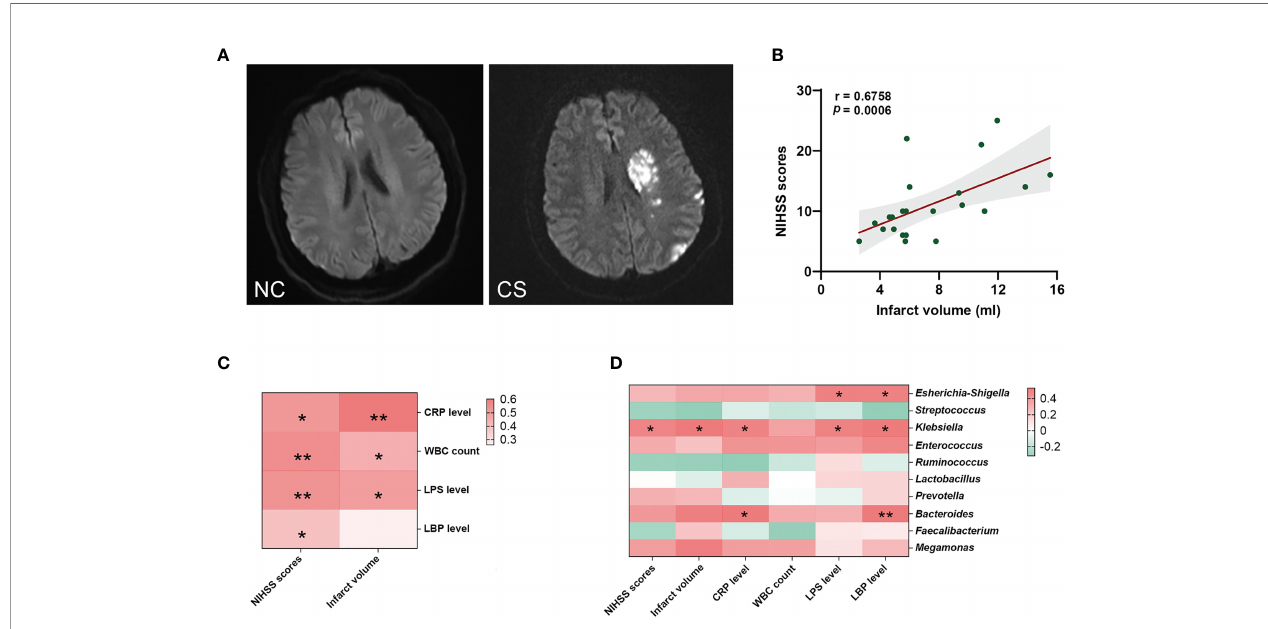
FIGURE 4 | Gut microbiota is associated with systemic in fl ammatory response levels and the severity of stroke. (A) Representative DWI image of the NCs (left) and CS patients (right). (B) The NIHSS scores positively related to the infarct volumes. (C) Heatmap of Spearman ’ s correlation analysis between systemic in fl ammatory factors and the severity of stroke. (D) Heatmap of Spearman ’ s correlation analysis between the abundance of gut microbiota and systemic in fl ammatory factors and the severity of stroke. p < 0.05 indicates statistical signi fi cance (* p < 0.05, ** p < 0.01). DWI, diffusion-weighted imaging; CS, cryptogenic stroke; NCs, normal controls; NIHSS, National Institutes of Health Stroke